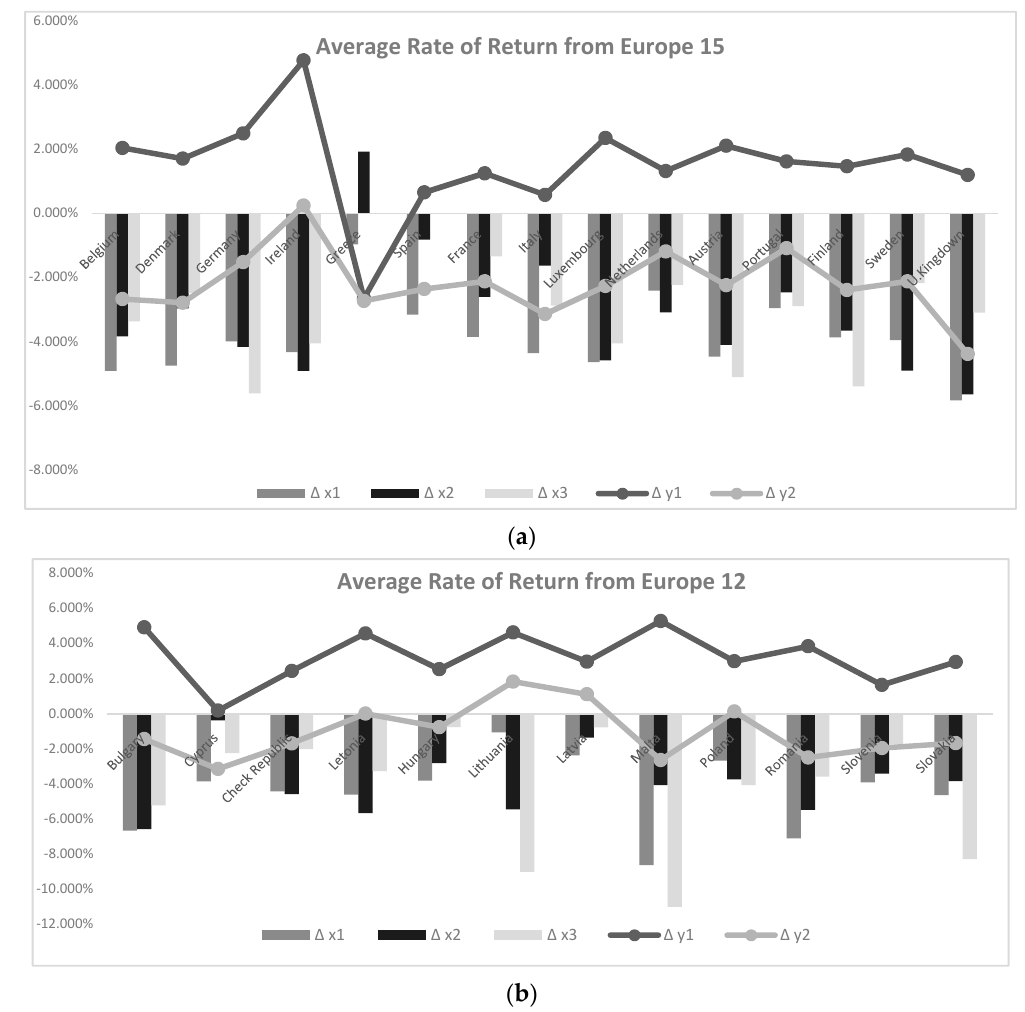
Figure 1. Evolution of the profitability rate of greenhouse gas emissions (GHG) emissions (x1, x2, x3 stand for CO 2 , CH 4 , N 2 O, respectively) in opposition to the evolution of the rate of return of the indicator of economic growth per capita (y1) and the rate of return of GHG (y2) for each country: ( a ) average rate of return from EU 15; ( b ) average rate of return from EU 12 (2008–2018 period).